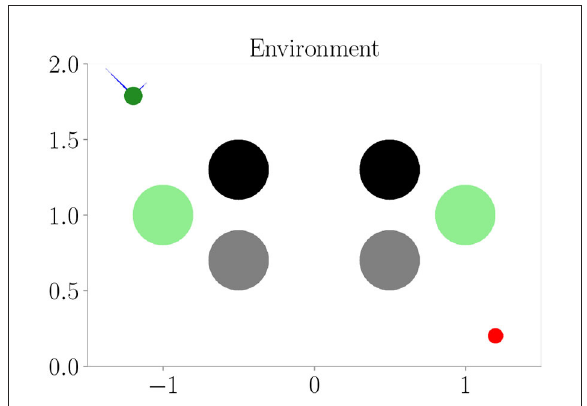
FIGURE8 One of the environments (hard condition) used in Experiment III–Behavioral-relevance of affordance codes (Section 4.5). Black and gray circles represent obstacles. They look different from the agent but have the same influence on behavior (i.e., path blockage). Green circles are as well seen by the agent but represent the open area and, therefore, mean the same as the white background